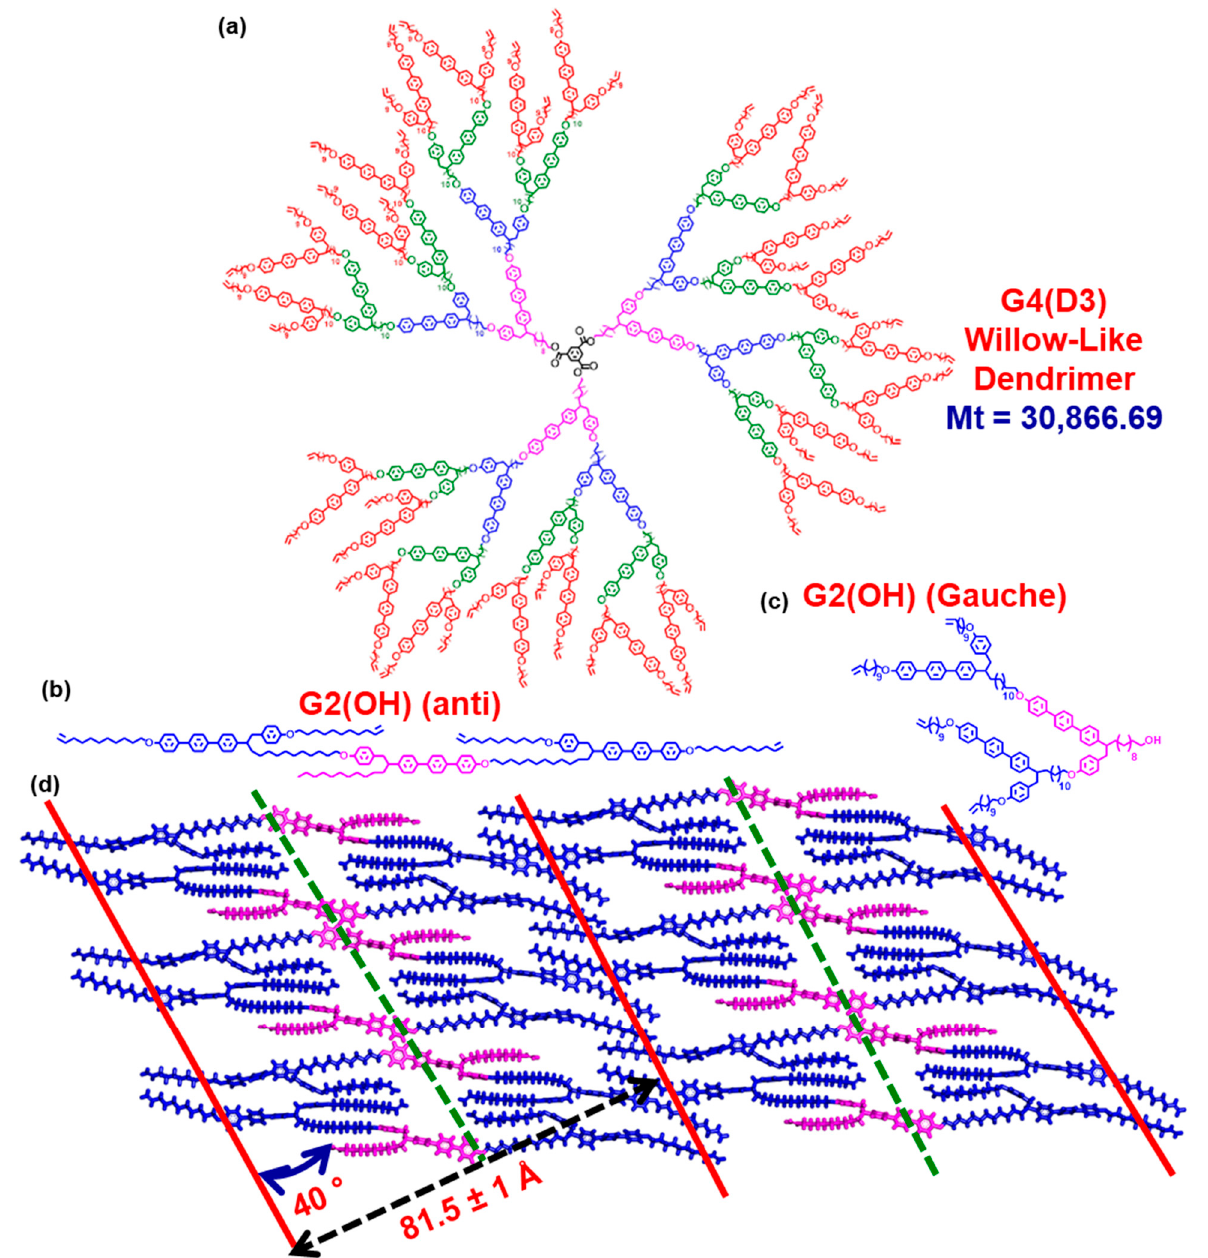
Figure 29. ( a ) Molecular structure of dendrimers G4(D3) ; ( b ) Molecular structure of dendron G2(OH) (anti), and ( c ) Molecular structure of dendrimers G2(OH) (gauche). ( d ) Molecular model of the smectic phase of G2(OH) . The magnetic field is almost horizontal [249].